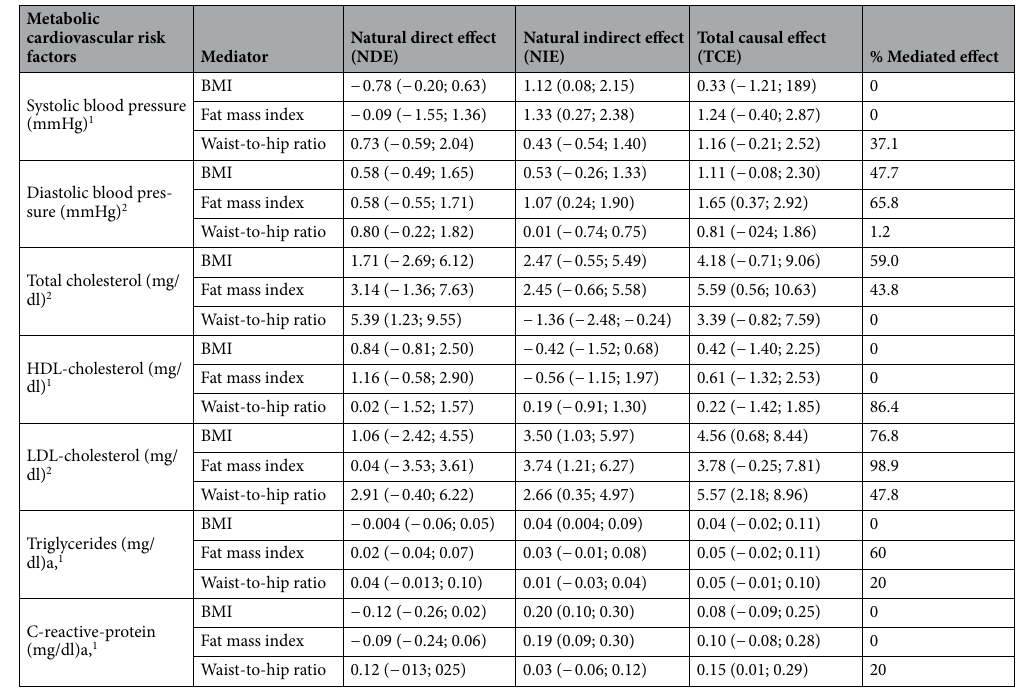
Table 4. Mediation analysis of the body composition on the association between age at menarche and metabolic cardiovascular risk factors at 30 years. a Logaritmo adjusted multiple regress. 1 p value > 5%. 2 p value ≤ 5%. TCE: NDE + NIE, total effect of the association between age at menarche and metabolic cardiovascular risk factors; NIE: effect of the association between age at menarche and metabolic cardiovascular risk factors through mediator; NDE: represent the effect of the association between age at menarche and metabolic cardiovascular risk factors controlled by mediator; e.g., TCE: the mean diastolic blood pressure increases, on average, 1.11 mmHg in women with menarche < 12 years, NIE: the mean diastolic blood pressure increases, on average, 0.53 mmHg when the effect through mediator BMI, NIE: the mean diastolic blood pressure increases, on average, 0.58 mmHg when the effect was controlled by mediator BMI. When the direct and indirect effect occurred in opposite directions, the mediated % is reported to be